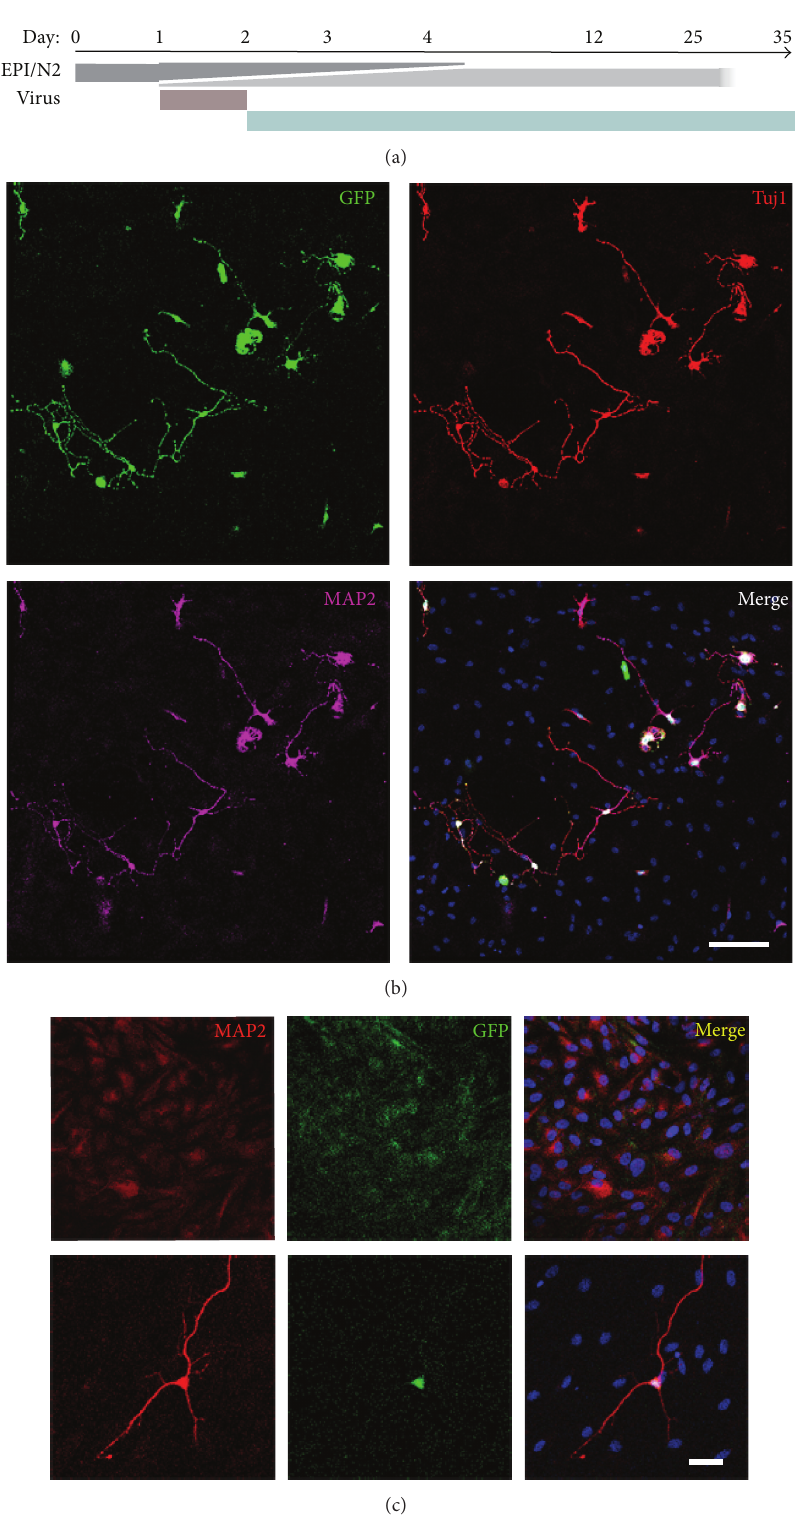
Figure 2: Generation of neurons from human urine cells. (a) Schematic protocol for conversion of urinary cells into neurons. (b) Twelve days after induction, urine derived-iN cells showed neuronal morphologies. And the urine-iN cells expressed both Tuj1 and MAP2. (c) Without the induction of DOX, the urine cells could not change into neuron cells (upper panel). In the presence of DOX, the DOX induced transcriptional factors (Ascl1, Brn2, NeuroD, c-Myc, and Myt1l) convert urine cells into neuron directly (lower panel). Scale bars, 50 𝜇